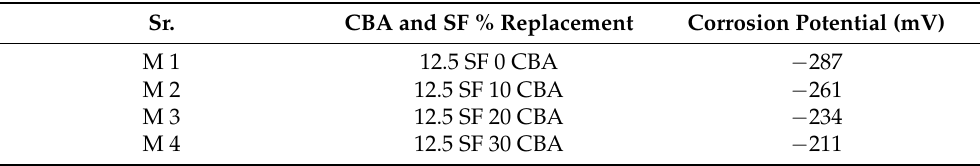
Table 3. Corrosion analysis of 90-Day’s sodium chloride solution.